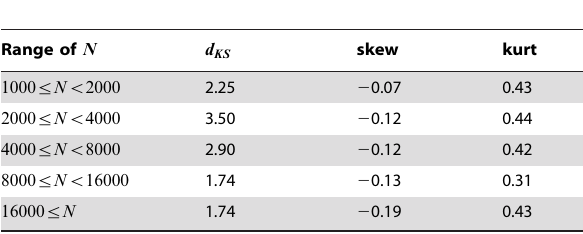
Table 6. KS distance ( d KS ) to a standardized Gaussian, and low-moment skewness (skew) and kurtosis (kurt) of aggregated distributions Q (cid:3) ( v ) . Data are aggregated over all countries for fixed N